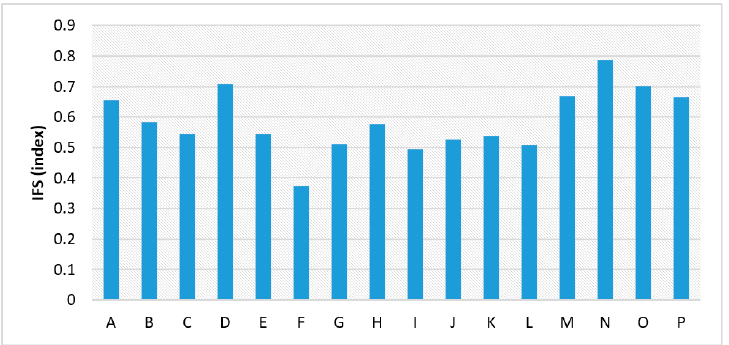
Figure 3. Integrated indicators of financial support for the textile enterprises development. Scheme 4 groups of textile enterprises were singled out (Table